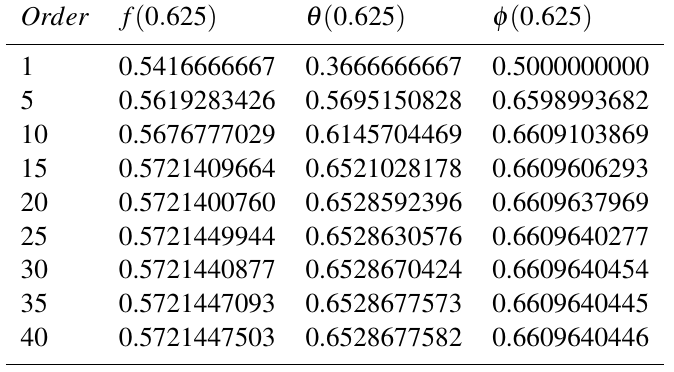
Table 1 Convergence of HAM solutions for different order of approximations